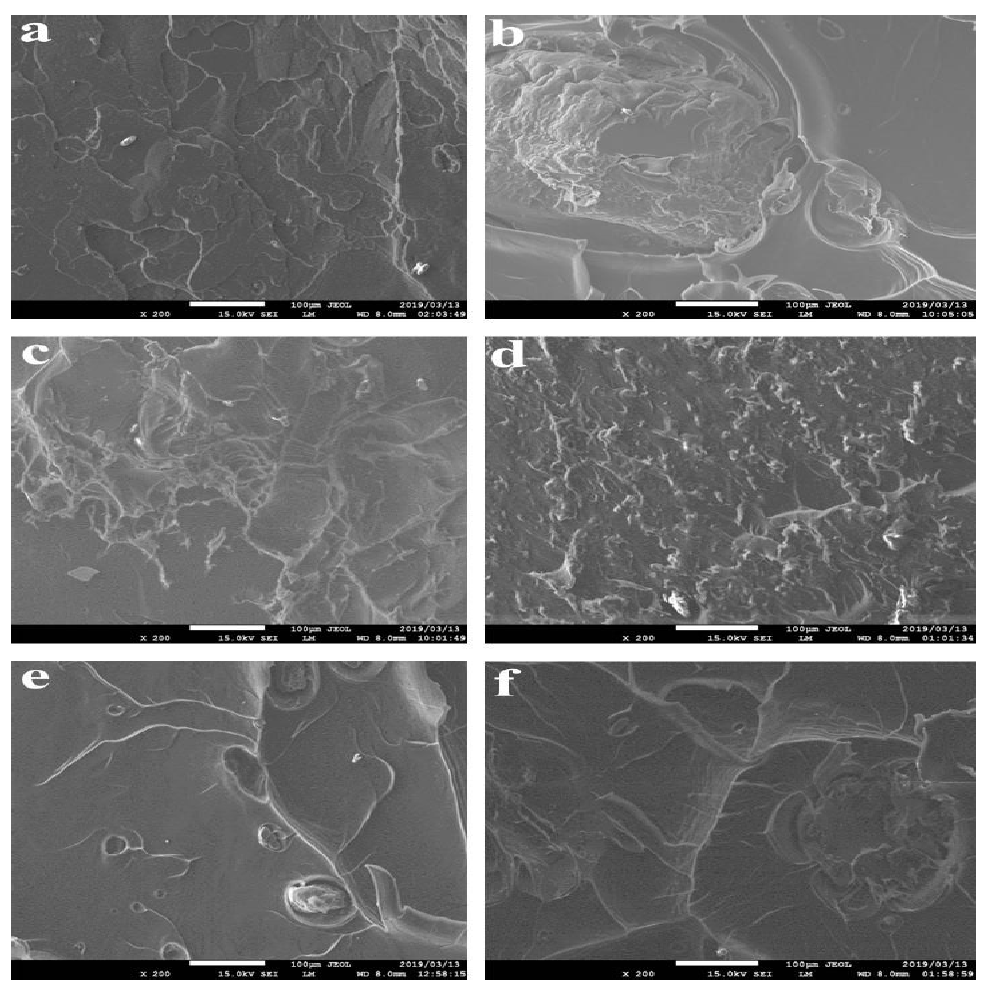
Figure 9. SEM fracture images. ( a ) 96% PLA–2% chitin–2% starch; ( b ) 96% PLA–4% chitin; ( c ) 96% PLA–4% starch; ( d ) 98% PLA–1% chitin–1% starch; ( e ) 98% PLA–2% chitin; ( f ) 98% PLA–2% starch.